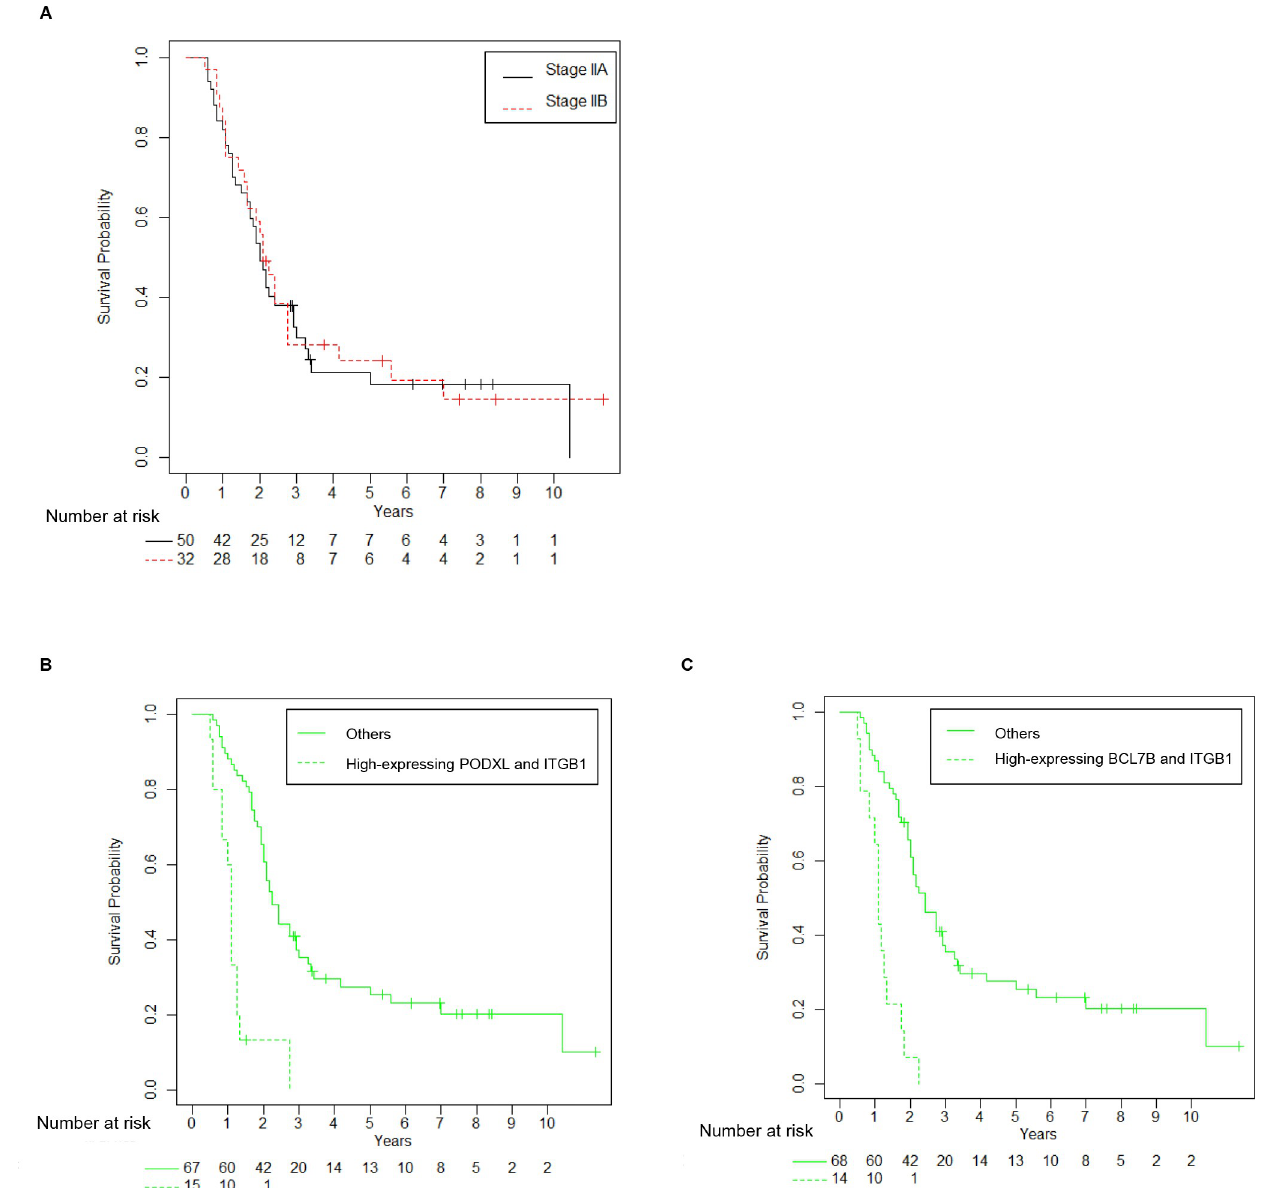
Fig 5. Correlation between high expression of two protein combinations and poor outcomes in PDAC patients at stage IIA and IIB. (A) Kaplan-Meier analysis of PDAC-related survival of patients with stage IIA and IIB tumors. The dashed lines represent the lower and upper limits of the 95% confidence interval. (B, C) Kaplan-Meier analysis of postoperative survival according to (B) the combination of PODXL with ITGB1 and (C) the combination of BCL7B with ITGB1 in stage IIA and IIB PDAC patients.